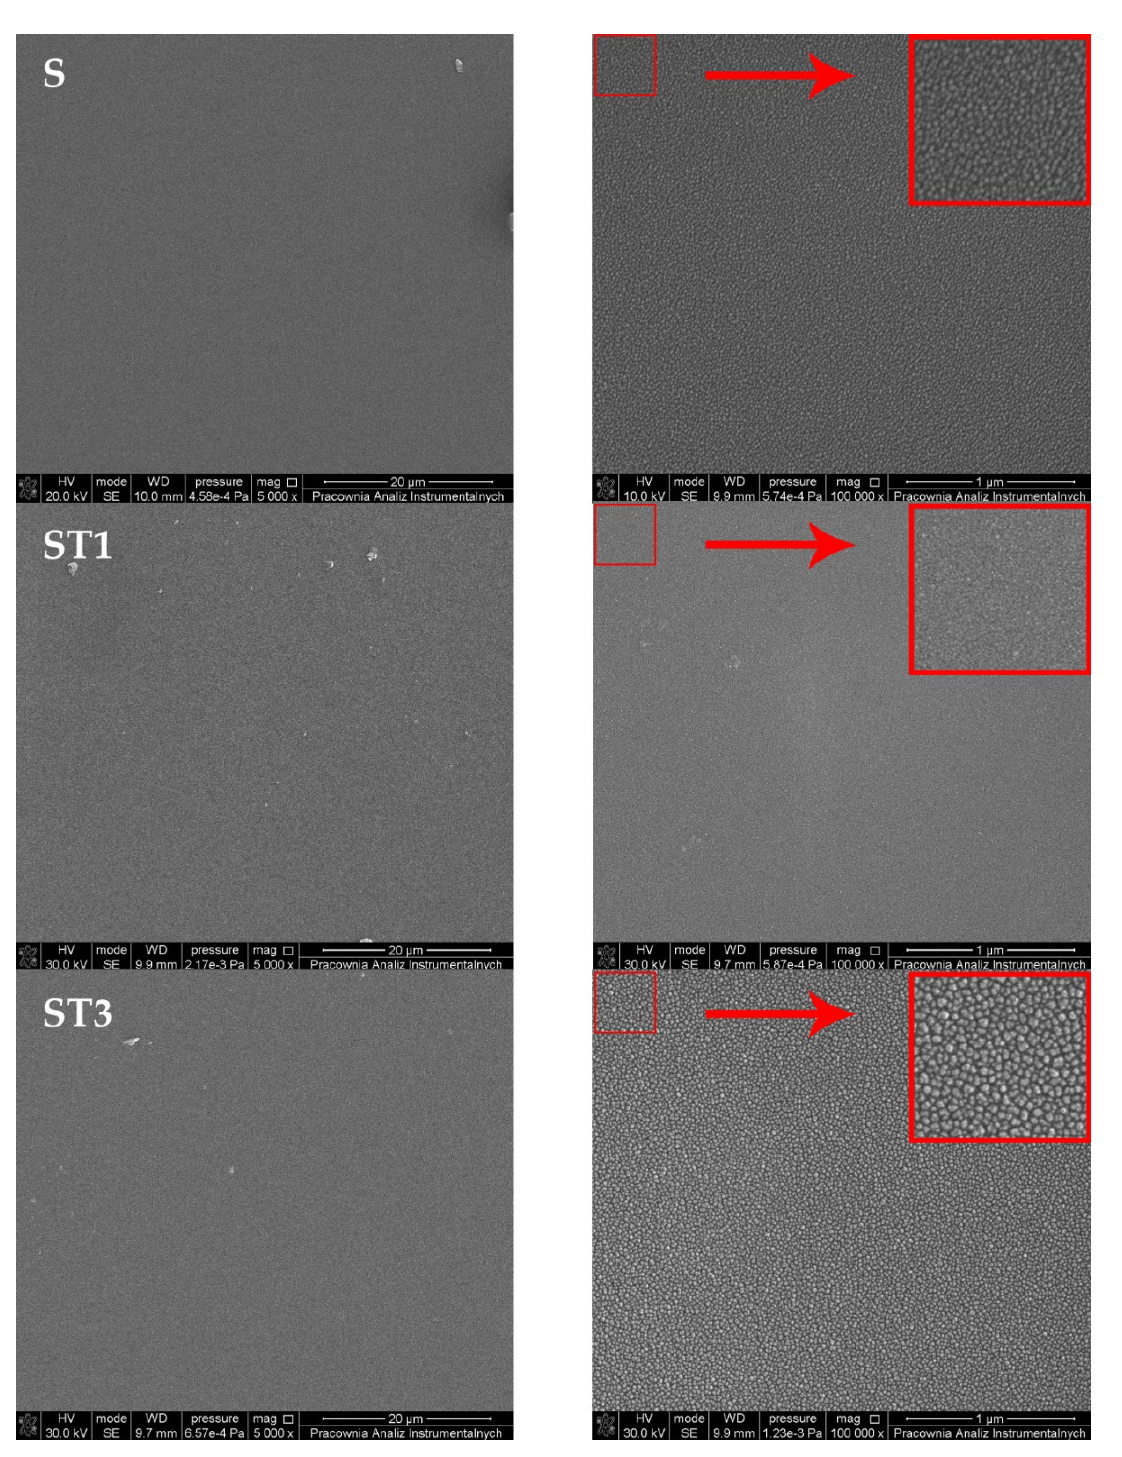
Figure 4. SEM images of elastomer and elastomer based composites filled with talc.